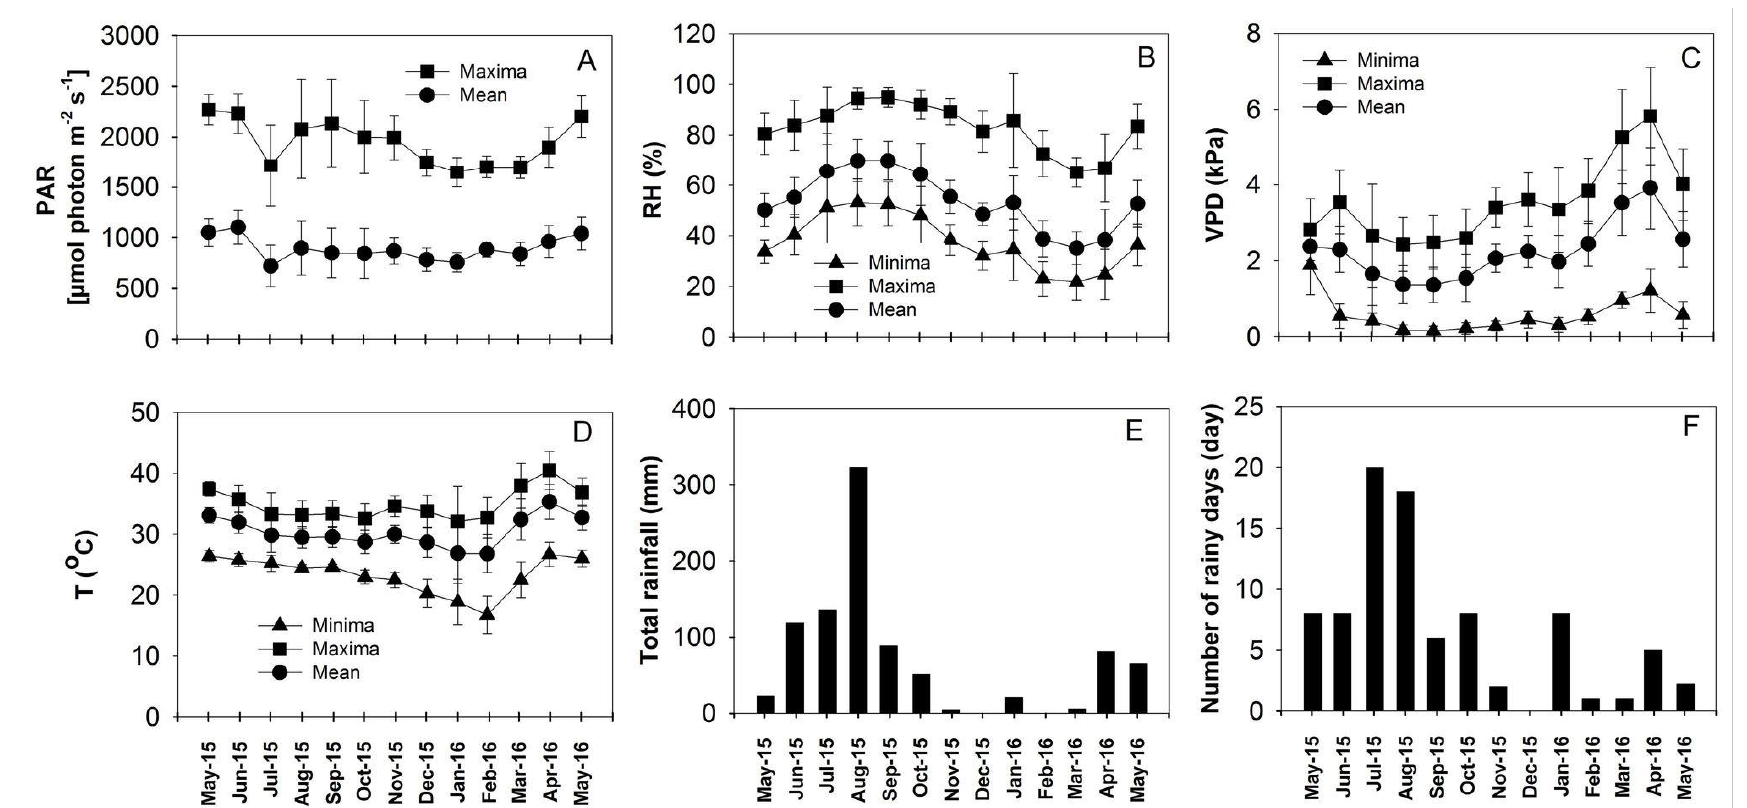
Figure 2. Weather conditions at the field site, including photosynthetically active radiation (PAR) ( A ), relative humidity (RH) ( B ), vapor pressure deficit (VPD) ( C ), air temperature (T) ( D ), total rainfall ( E ), and number of rainy days ( F ) recorded during May 2015 to May 2016. Values are mean ± SD of 30 days .